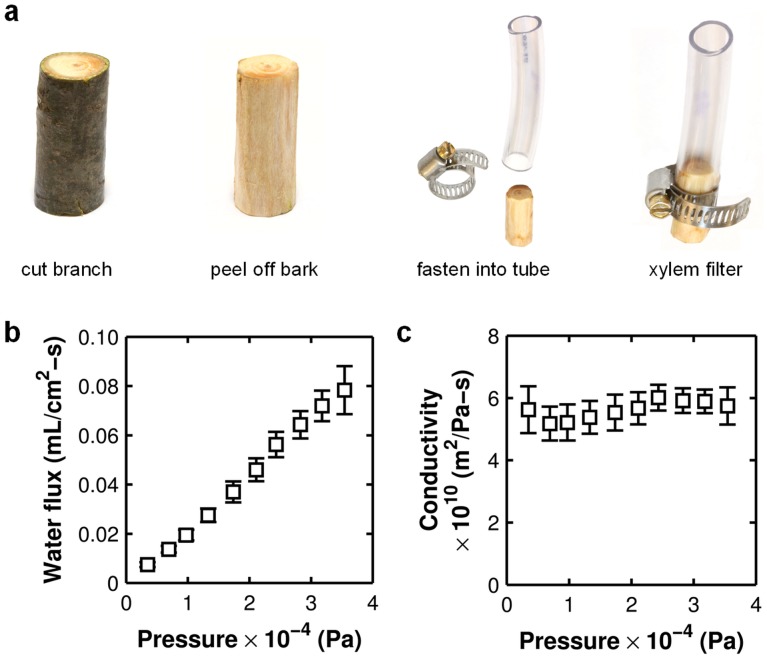
Xylem filter.a) Construction of xylem filter. b) Effect of applied pressure on the water flux through the xylem filter. c) Hydrodynamic conductivity of the filter extracted at each measured pressure using the total filter cross-section area and thickness as defined by Equation 1. Error bars indicate ±S.D. for measurements on three different xylem filters.